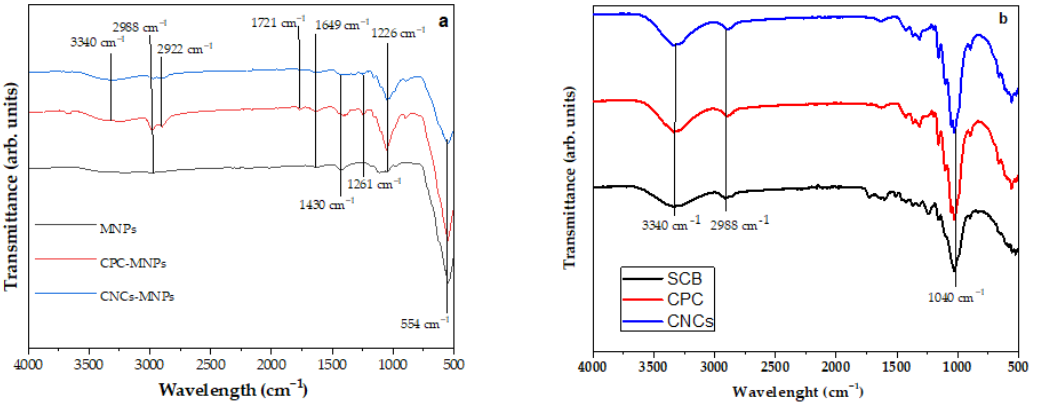
Figure 4. FTIR spectra: ( a ) MNPs, CPC-MNPs, and CNC-MNPs; ( b ) SCB, CPC, and CNC. Peaks between 1430 and 1420 cm − 1 in the identical spectra of CPC-MNPs and CNC- MNPs are due to the CH 2 scissoring motion in cellulose. Additionally, the spectral peaks between 1727 to 1721 cm − 1 of both cellulosic materials composites shifted to 1226 and 1601 cm − 1 . After the structural modification of the cellulosic materials, the peaks around 2988 and 2292 cm − 1 , which are associated with the C-H stretching of the cellulosic materials, persisted, though with slight reductions in intensity. This observation indicated that the structural properties of the cellulosic materials were not completely altered. Additionally, the presence of the peaks at 2922 and 554 cm − 1 of the prepared nanocomposites confirmed successful incorporation. 3.3. Thermal Properties The experimental research of thermal properties of materials (TGA- DTG) is a dy- namic phenomenological technique for studying the response to temperature change. Thermalgravimetric curves reveal weight changes during heating, whereas their deriva- tion indicates changes in the TGA slope which may not be easily observed. The thermal characteristics of the produced MNPs and cellulosic composites were investigated to de- termine their thermal stabilities (Figure 5a). The TGA results confirmed that MNPs were stable. There is no observable mass change throughout the degradation curve from 30 to 600 °C. Additionally, in Figure 5a, multi-step degradation for CPC-MNPs and CNC- MNPs is seen at temperatures below 150 °C, resulting from the loss of moisture absorbed by the composites [44]. Furthermore, the weight loss in the composites preceded the moisture loss. The weight loss between 150 and 230 °C was a result of the hemicelluloses that were not elim- inated in the preparation and synthesis of both the CPC and CNC (Figure 5b) [45]. The weight loss was more pronounced in CPC-MNPs in comparison to CNC-MNPs, indicat- ing that CPC-MNPs had much lignin and hemicellulose. According to a similar study, Candido et al. [45] found that, at about 230–460 °C, the weight loss resulted from lignin that was not eliminated. For the MNPs, the slow weight loss between 220 and 330 °C re- sulted from the dihydroxylation of Fe 3 O 4 to FeO [35]. Moreover, the weight loss of the nanocomposites from 310 to 470 °C was due to the reduction of Fe 2 O 3 to Fe 3 O 4 , with the release of CO [46]. Above 480 °C, there was an increase in the weight of the MNPs; this is attributed to the oxidation of magnetite at higher temperatures. The final decomposition of the composites between 480–600 °C involved weight loss of the solid residue—slight weight loss of between 10–12%. The absolute weight loss of the MNPs was less than 5%, whereas for CNC-MNPs it was 16%. CPC-MNPs had the largest absolute weight loss of approximately 20% [47]. The reduced thermal stability of CNC-MNPs resulted from rem- nant sulfate ions used in the hydrolysis of CPC. This is because the elimination of sulfated anhydrous-glucose units requires lower temperatures [48]. The composition of the